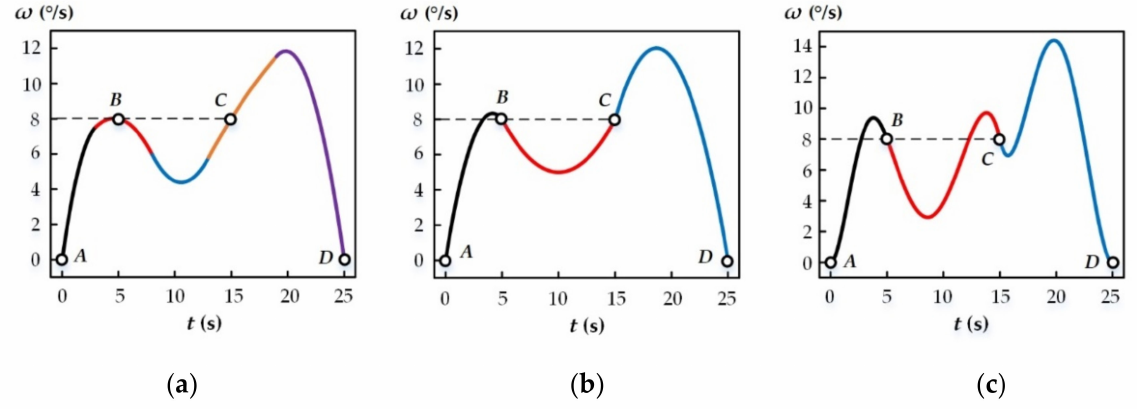
Figure 14. Angular velocity comparison: ( a ) Proposed methodology planning; ( b ) Cubic polynomial planning; ( c ) Quintic polynomial